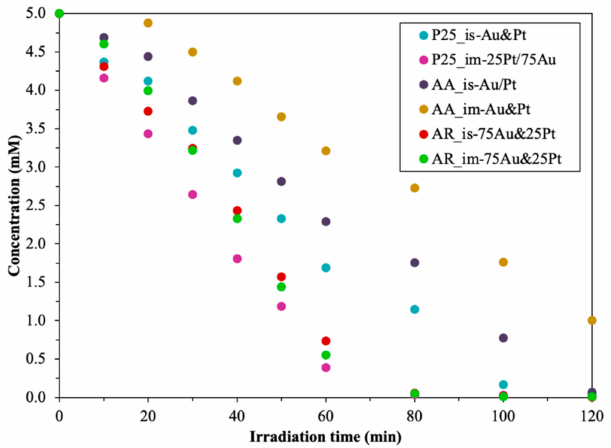
Figure 8. Degradation curves for oxalic acid—those composites are marked that had the best activity for each base catalyst (Evonik Aeroxide P25 (P25), Aldrich anatase (AA), Aldrich rutile